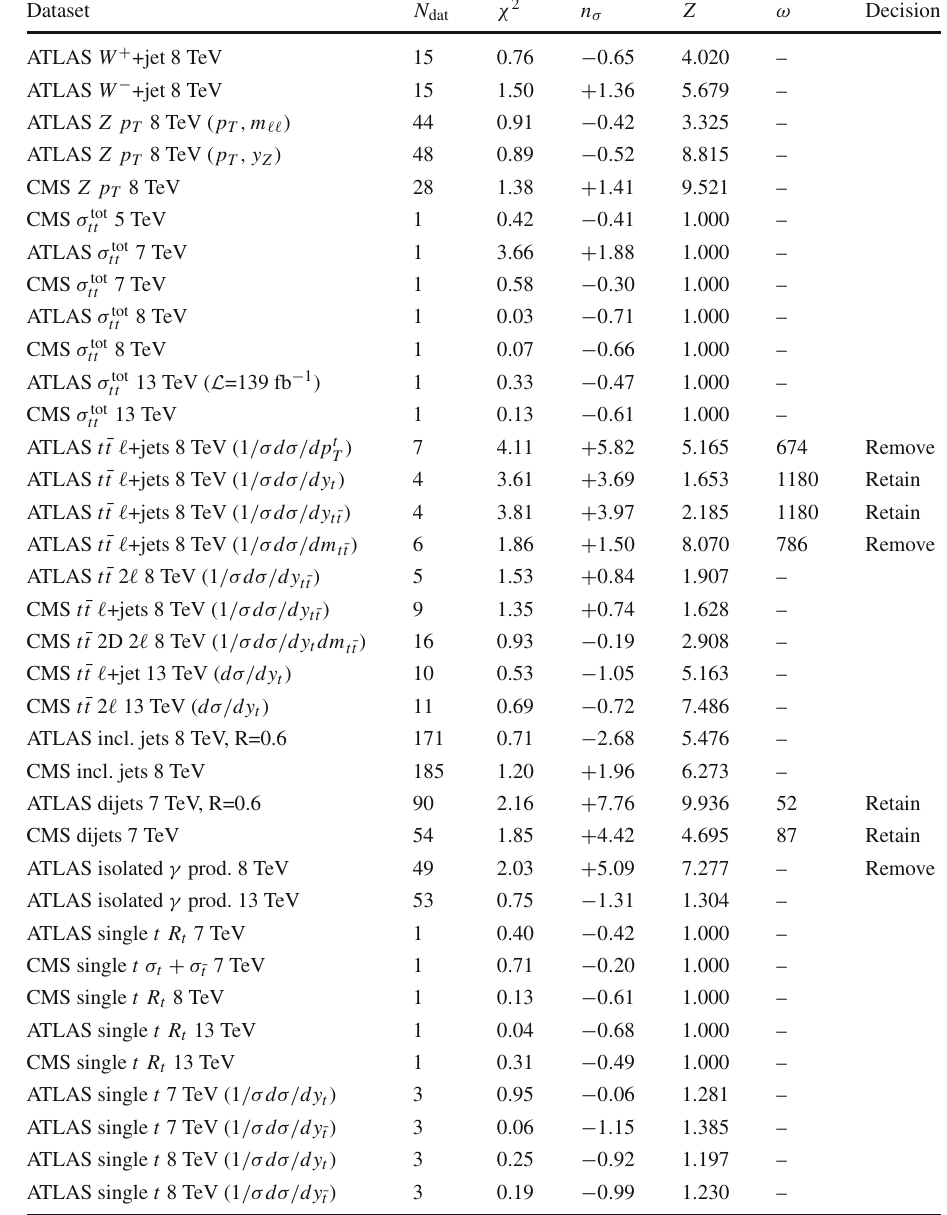
Table 15 Same as Table 12 for other LHC processes (listed in Table 5)